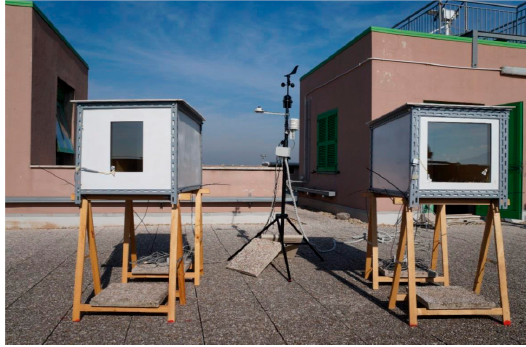
Figure 4. STB test for the new frame calibration.